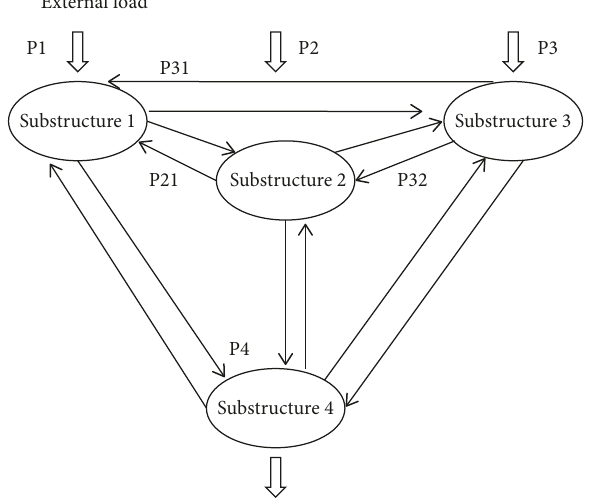
Figure 2: SEA model of four